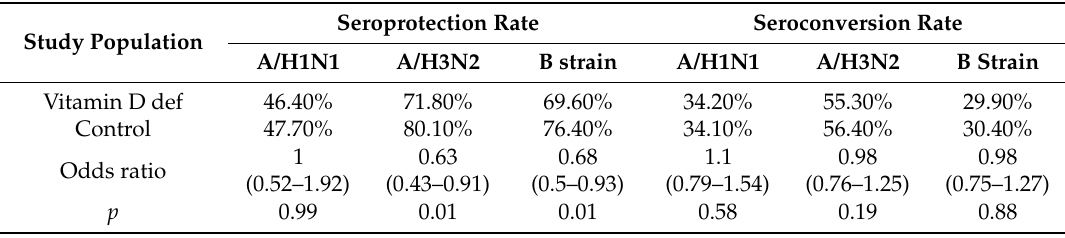
Figure 3. Forrest plot of the seroconversion (SC) rates of influenza vaccination in the VDD and placebo groups. ( a ) Strain A/H1N1; ( b ) strain A/H3N2; ( c ) strain B. Table 2. Immunologic responses for influenza vaccination between VDD and control